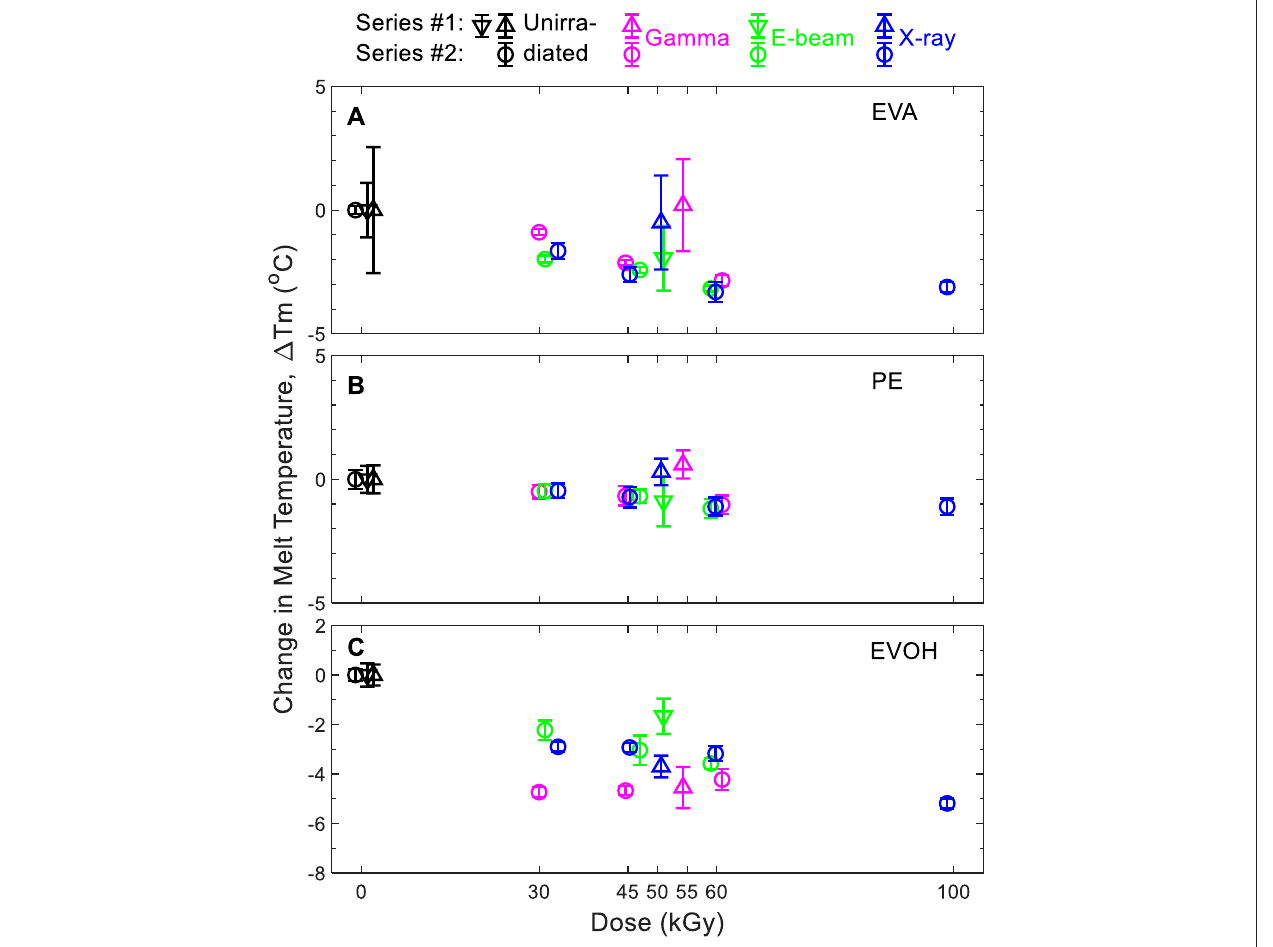
FIGURE2| Changeinmeltingtemperaturesof (A) EVA, (B) PE,and (C) EVOHcomponentswithrespecttonon-sterile fi lms.Triangles:series#1.Circles:series#2. Trianglespointingupanddownrepresent dataobtainedforsamplesfromtwodifferentmanufacturingbatches.RepresentativeDSCresponsesofEVA/EVOH/EVA fi lms (series 2) are shown in Supplementary Figure S1